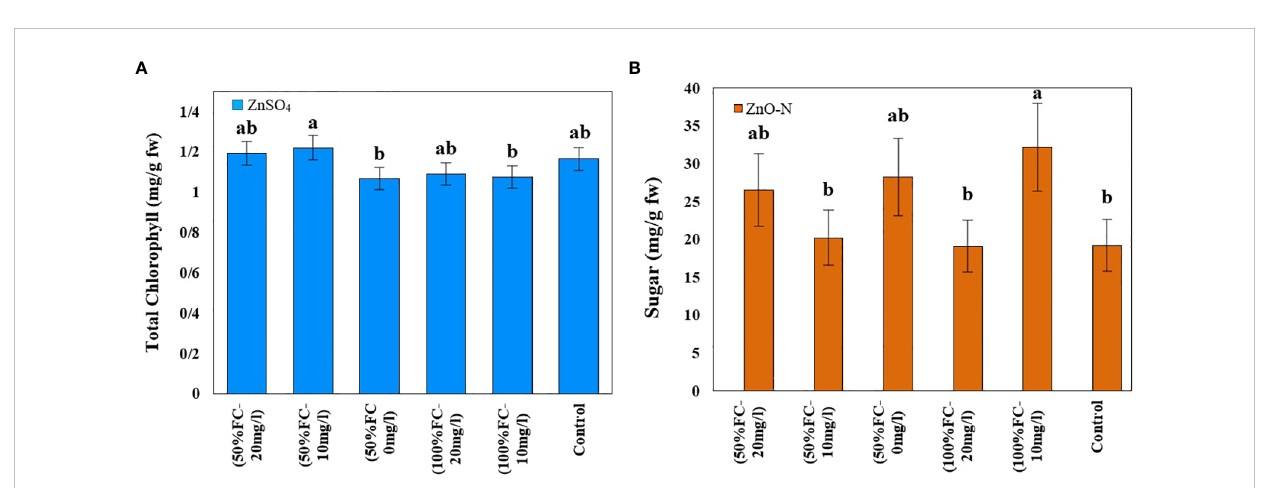
FIGURE 3 Impact of ZnSO 4 on total chlorophyll (A) and ZnO-N on sugar (B) in D Kotschyi under Drought Stress. Means followed by the same letters did not differ signi fi cantly at p ≤ 0.05, n =